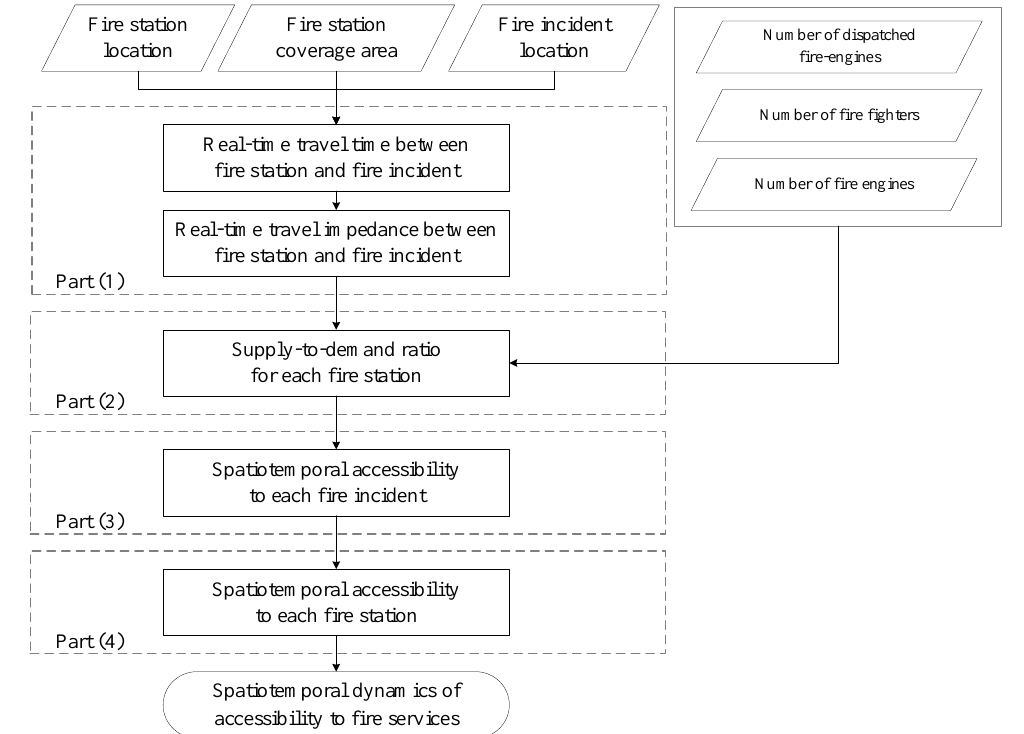
Figure 2. Flowchart of the spatiotemporal pattern of accessibility of fire services in Nanjing, China.